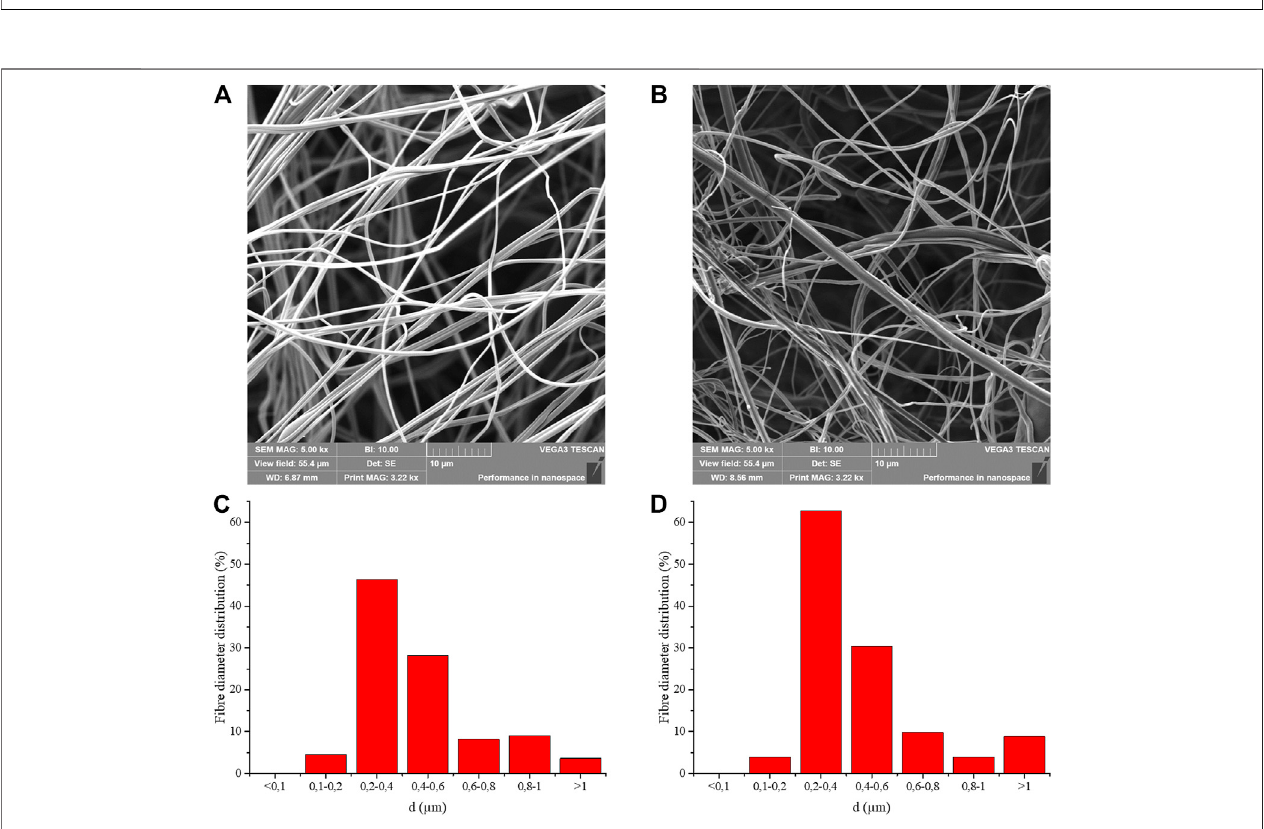
Frontiers in Materials |